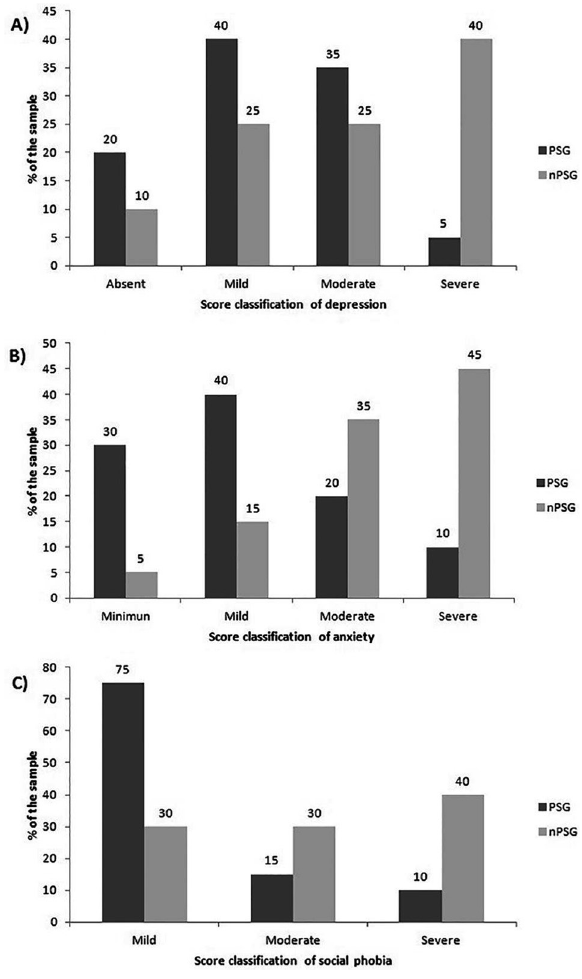
Figure 1. Classification of individuals according to depression, anxiety and social phobia scores.